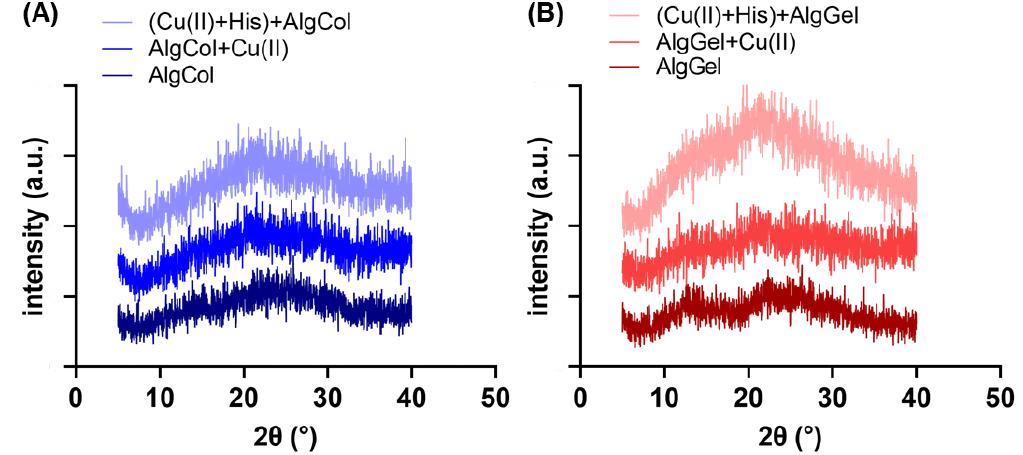
Figure 2. XRD spectra for ( A ) AlgCol and ( B ) AlgGel before and after copper adsorption. Infrared spectra evidenced features of alginates and the differences between AlgCol and AlgGel composition (Figure 3A,B). Characteristic bands for alginate are observed at 3340 cm − 1 , attributed to O-H hydrogen bonds stretching; 2930 cm − 1 due to C-H stretching vibrations; 1600 cm − 1 , which corresponds to the COO − asymmetric stretching of carboxylate anions; 1410 cm − 1 , attributed to vibrational deformation of the O-H bond with contribution from the carboxyl group C-O stretching; and at 1295 cm − 1 , 1080 cm − 1 , 1030 cm − 1 , and 940 cm − 1 , attributed to the stretching of the C-O and C-C bonds of uronic acid residues [37–40]. Those bands may also indicate the dimerization of poly-G-sequences with the calcium ions of the crosslinking agent on its interior [41]. The main changes from one alginate type to another are found in 1320, 1100, and 1080 cm − 1 (characteristic bands of guluronic acid) and at 1290 cm − 1 and 880 cm − 1 , attributed to mannuronic acid residues.